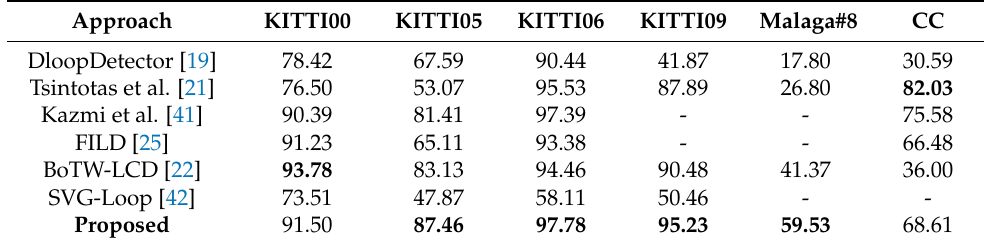
Table 3. Recall rates at 100% precision of different